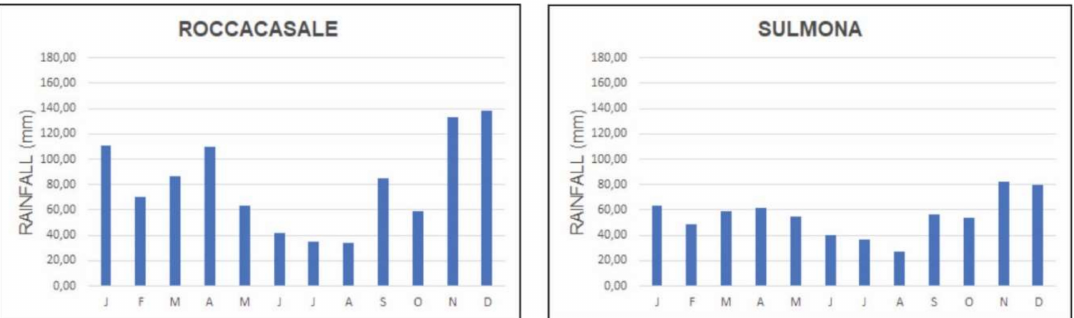
Figure 9. Pluviometric regime of Roccacasale and Sulmona pluviometric stations, located next to the study area.